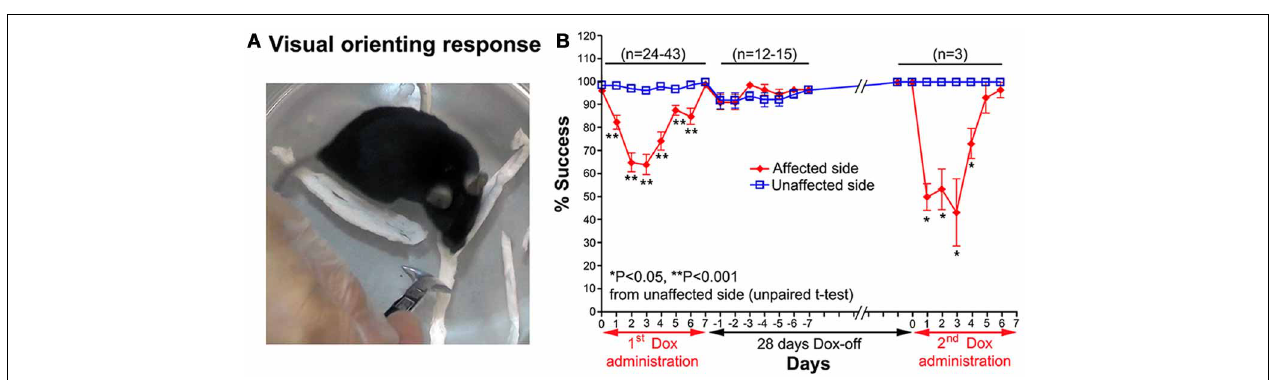
Tet-induced tetanus neurotoxin-expressing system on the visual placing response toward the affected side after the 1st Dox administration for 7 days, termination of Dox administration for 28 days, and the 2nd Dox administration for 7 days.